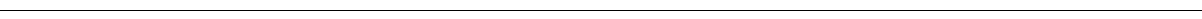
Fig. 6 Predicted vs. measured concentrations of inorganic ions and some metabolites in real urine samples. Plots of the predicted vs. measured concentrations of 11 inorganic ions in 60 real urine samples, and of 6 among the most active metabolites in 120 real urine samples. The panels show: a chloride (Cl − ), b sodium (Na + ), c calcium (Ca 2+ ), d potassium (K + ), e magnesium (Mg 2+ ), f phosphate (PO 4 3 − ), g sulfate (SO 4 2 − ), h lithium (Li + ), i rubidium (Rb + ), j zinc (Zn 2+ ), k aluminum (Al 3+ ), l creatinine, m dimethylamine, n creatine, o hippurate, p guanidoacetate, and q tartrate. Additional panels for another set of six metabolites are reported in Supplementary Fig. 5. The concentrations of the inorganic ions were determined in clinical analysis and analytical chemistry laboratories, and the metabolite concentrations were estimated by NMR lineshape fi tting analyses (Methods). Horizontal error bars for ions indicate con fi dence intervals according to the estimated errors of the analytical technique used (Methods), and the vertical ones both for ions and active metabolites are based upon the accuracy of each predictive model, extracted from the relative root mean square error (rRMSE) values. In turn, the rRMSE values were calculated by the predictive ef fi ciency of the models in the 40 randomly prepared arti fi cial urine mixtures (Supplementary Fig. 3) and the 4501 arti fi cial urine spectra. For the cases of h Li + and i Rb + , 10 and 6 urine samples, respectively, lie outside the normal concentration range in urine, as highlighted by an additional panel. It can be seen that the models are able to predict also these outliers with high accuracy. In addition, the diseases involving alterations of each of the reported ions are reported in orange panels, with the black arrows in the parentheses showing the concentration trend of the ion for each